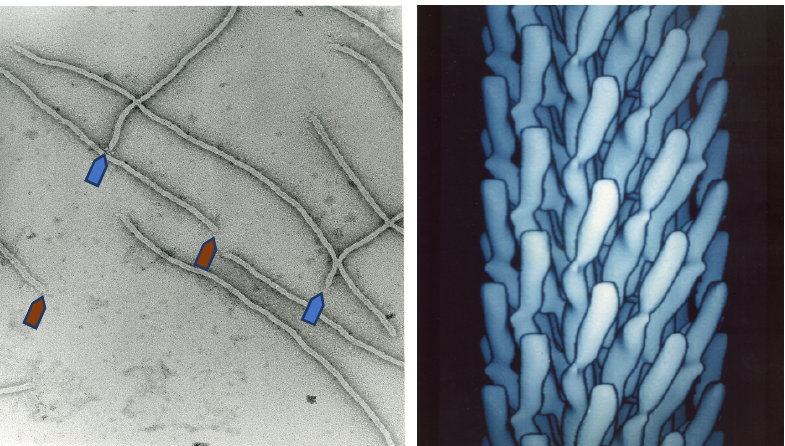
Figure 1. Electron microscopy image of filamentous phage ( left ) and electron density model ( right ) of filamentous phage M13 (Courtesy of Lee Makowski and Gregory Kishchenko. Adapted from [8]). Blue and red arrows depict the sharp and blunt ends of the phage capsid with attached minor coat proteins pIII/pIV and pVII/pIX, respectively (five copies each). Major coat protein (~2700 copies) forms the tubular capsid around viral single-stranded DNA.